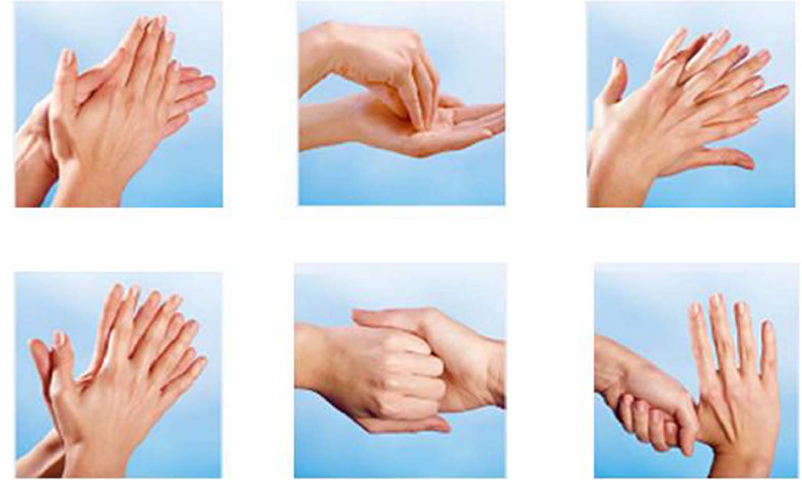
Figure 1. Hand disinfection steps according to EN1500.